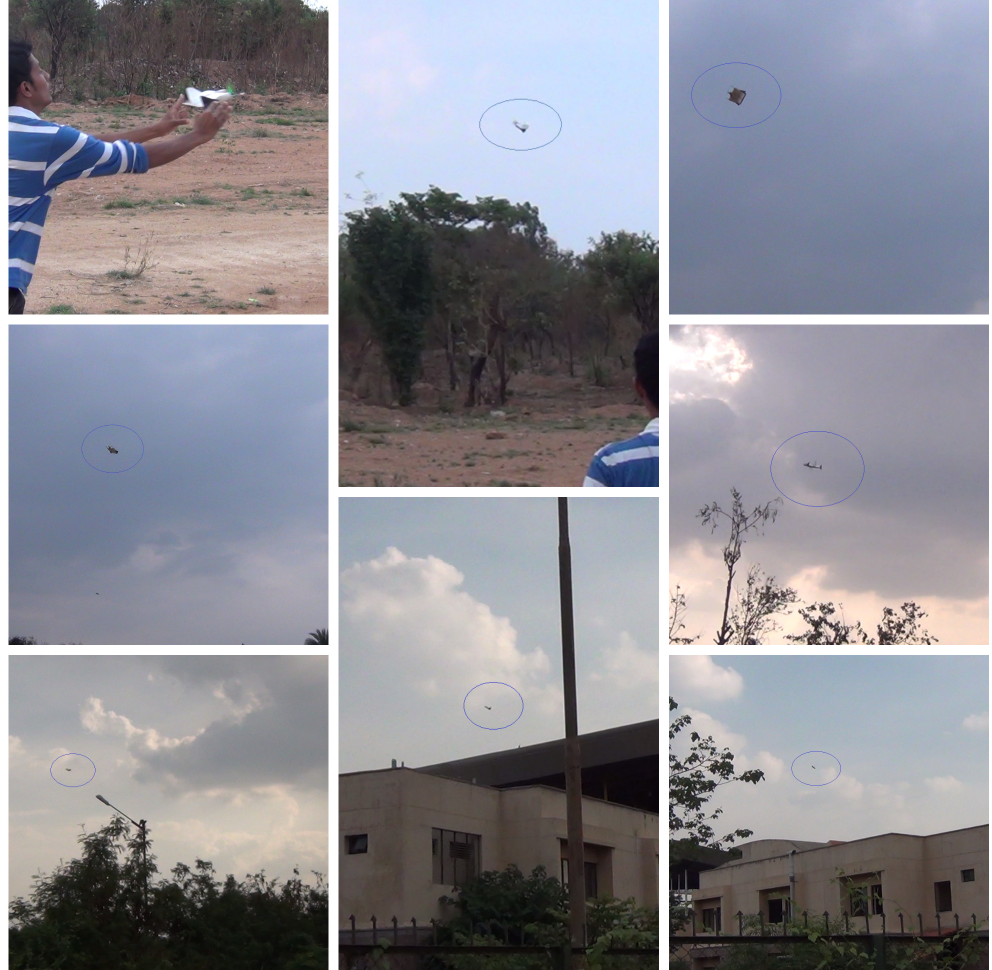
Figure 15. Photograph showing MAV